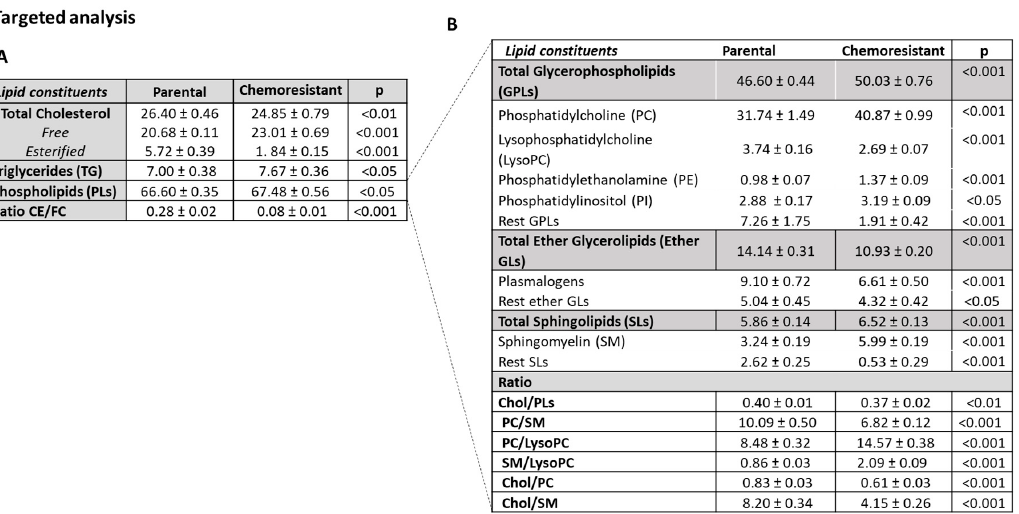
Table 1. Fatty acid profile of the lipid extracts from PTX-res and parental cells. Values are expressed in percentages of total lipids (mol/100 mol of Total Fatty Acids) and are means ± SD.